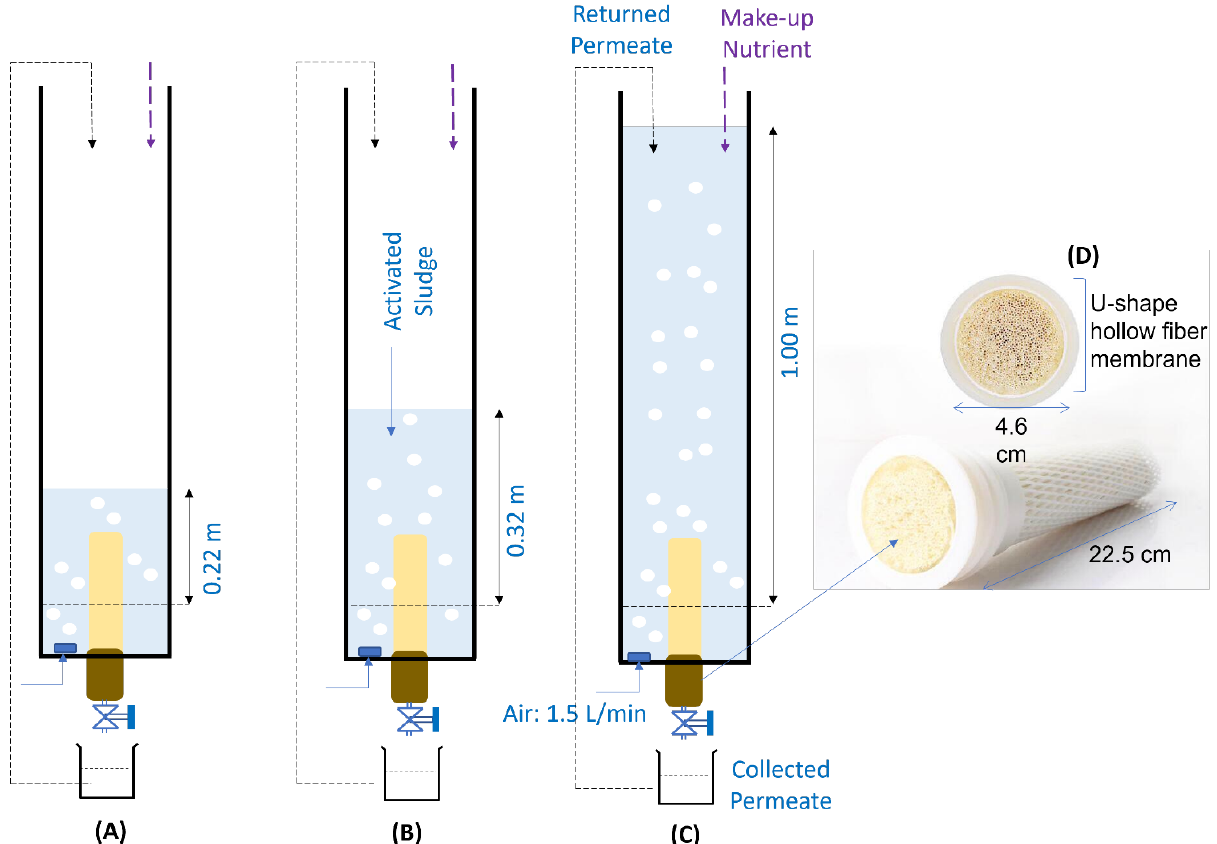
Figure 1. Illustration of the three reactors used for the experiment ( A – C ) and the picture of U-shape hollow fiber membrane installed in the reactors (D).